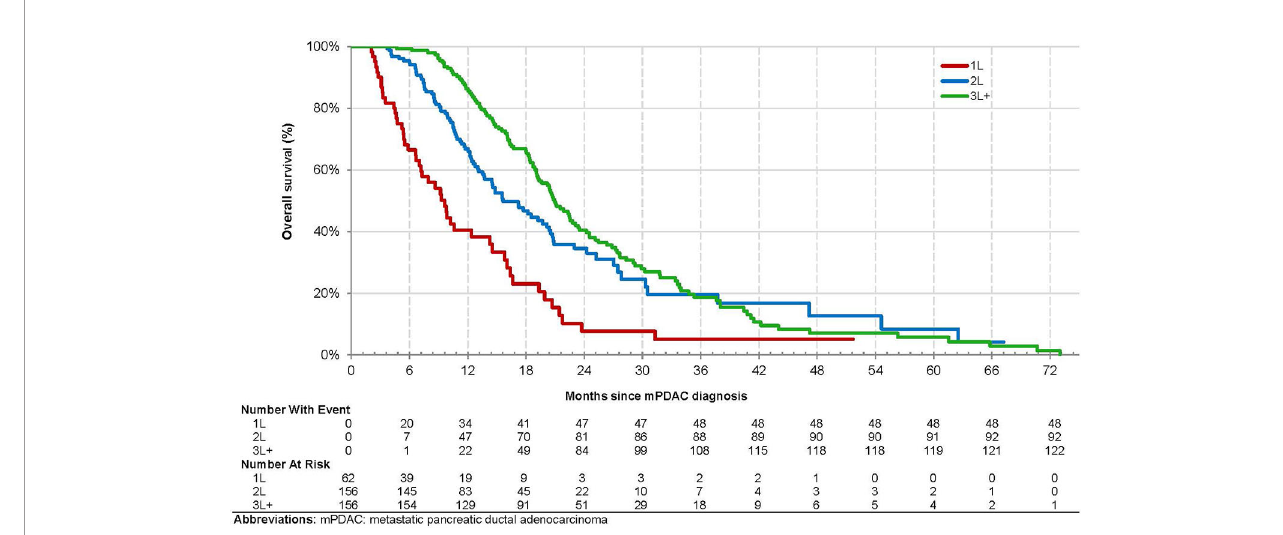
FIGURE 2 | Kaplan-Meier Analysis of Overall Survival from mPDAC Diagnosis among Patients with mPDAC Treated with Liposomal Irinotecan in a Doublet with 5-Fluorouracil.